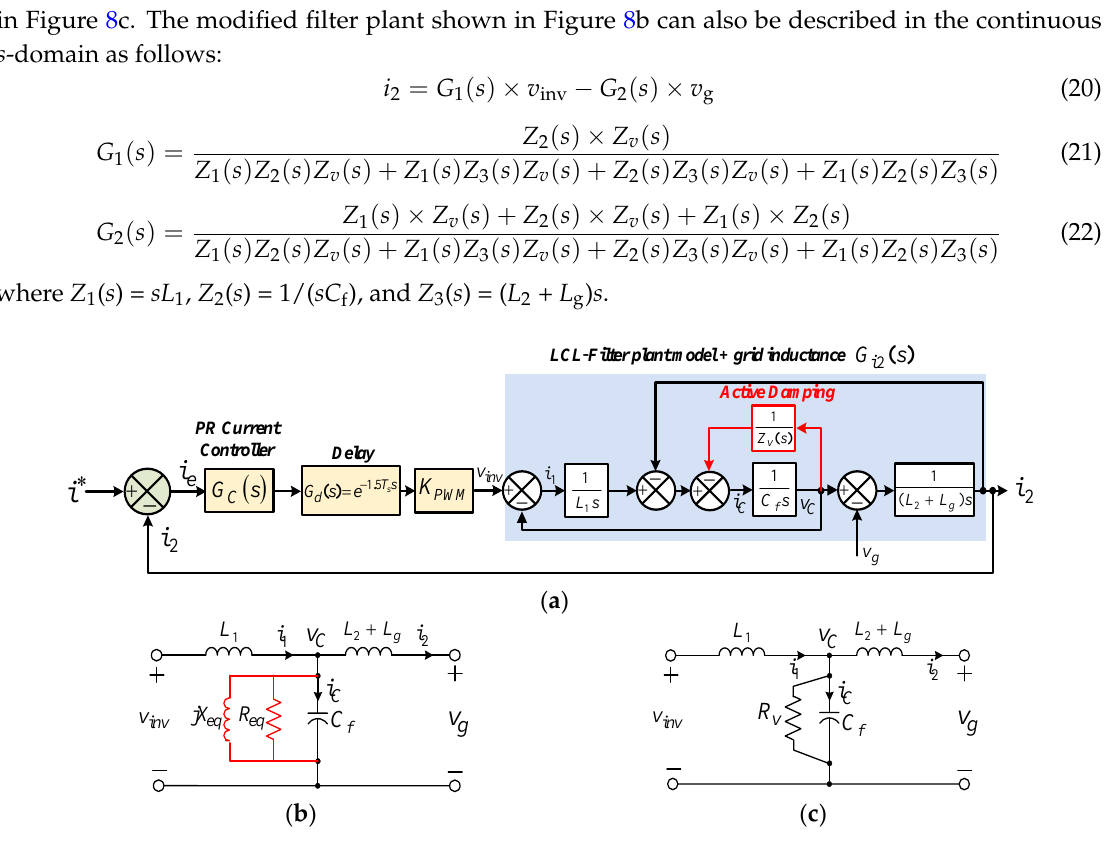
Figure 8. Equivalent control diagram and filter equivalent circuit for the proportional CCF AD scheme: ( a ) control diagram representation; ( b ) filter equivalent circuit with considering system delays; and ( c ) filter equivalent circuit without considering system delays.